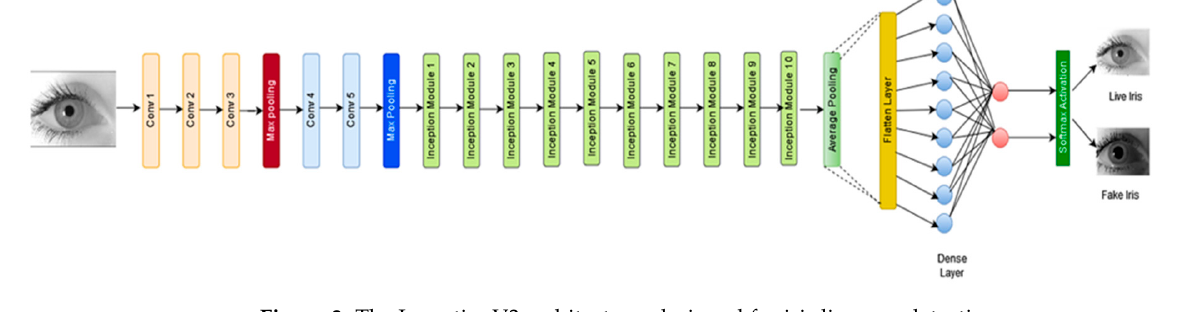
Figure 3. The InceptionV3 architecture, designed for iris liveness detection.